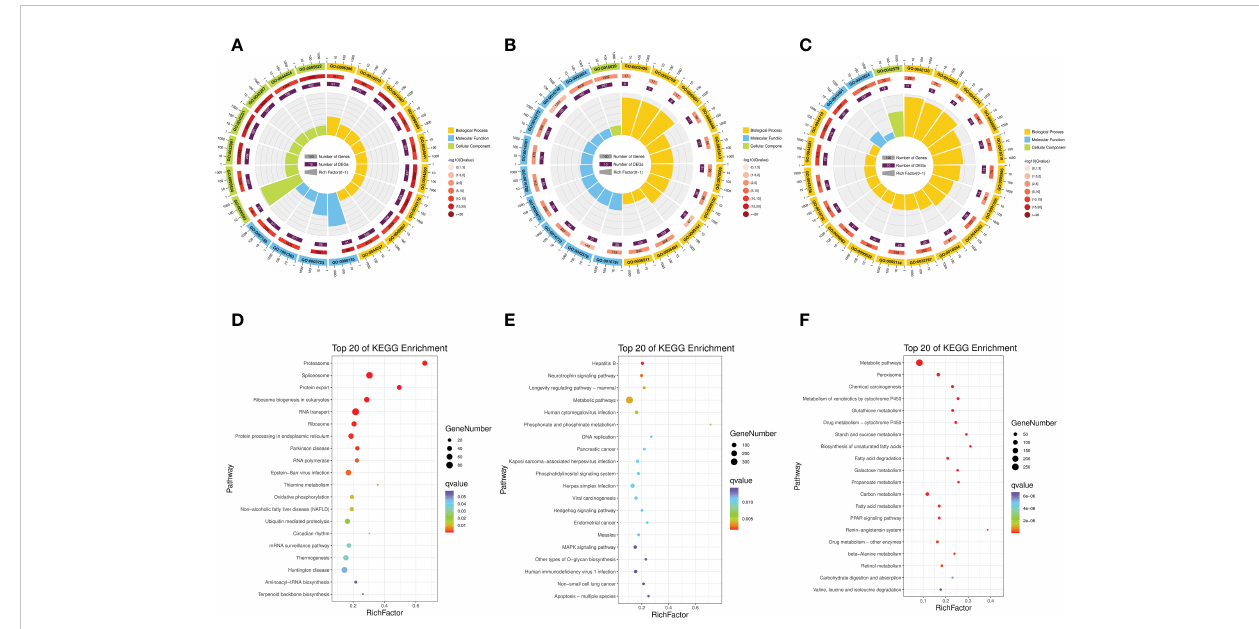
FIGURE 2 Gene Ontology (GO) enrichment analysis of genes in blue module (A) , darkslateblue module (B) and yellow module (C) . Kyoto Encyclopedia of Genes and Genomes (KEGG) enrichment analysis of genes in blue module (D) , darkslateblue module (E) and yellow module (F)